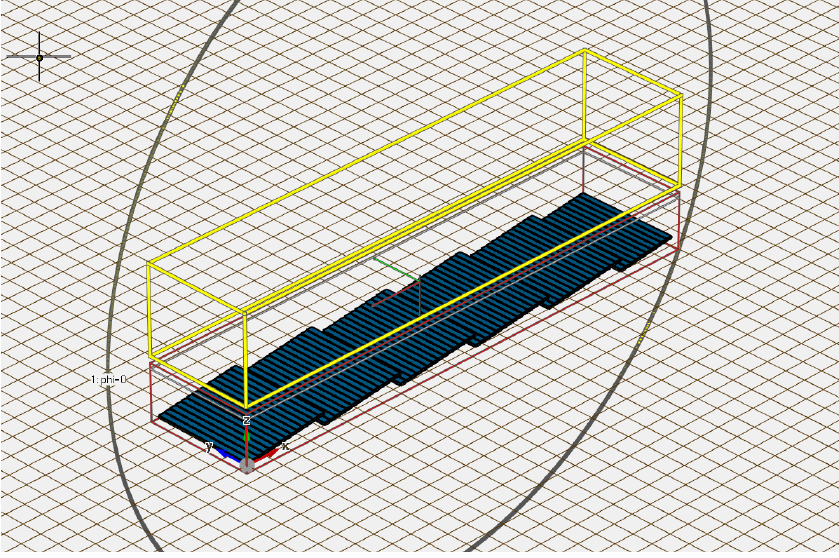
Figure 11. Electromagnetic simulation setup in the FDTD